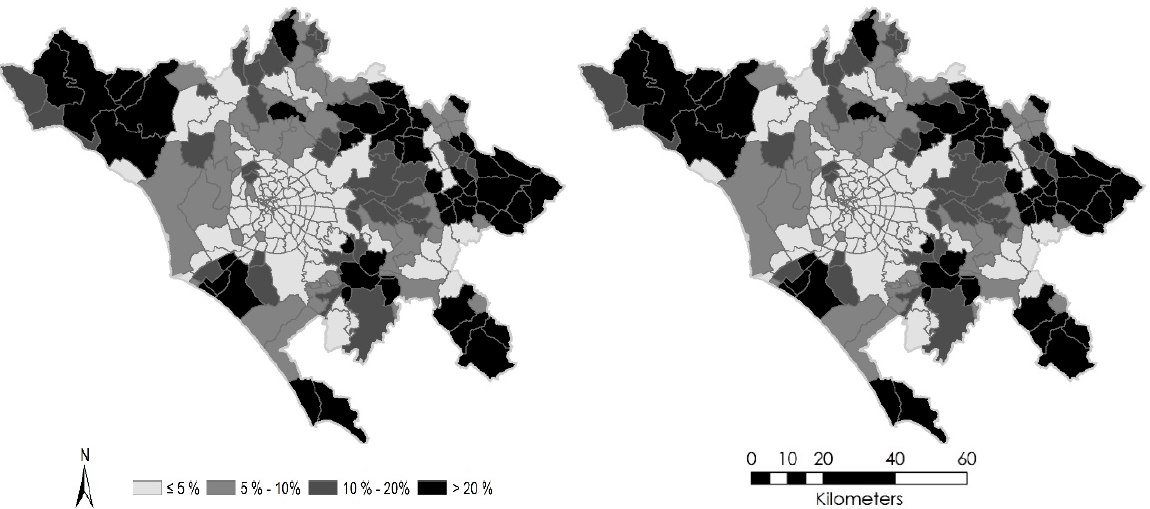
Figure 5. The spatial distribution of percent share of forest cover in the total municipal (or district) area in Rome ( left : 1936; right : 2018). Table 1. Correlation coefficients and best-fit R 2 of global econometric models (Ordinary Least Squares (OLS) with linear and non-linear specifications; Geographically Weighted Regression (GWR) estimating the percentage of forest area in each spatial domain (dependent variable) from the distance to downtown Rome (predictor) by